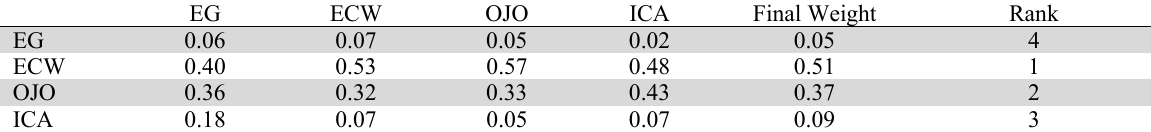
Normalized Matrix and weight of goal EG